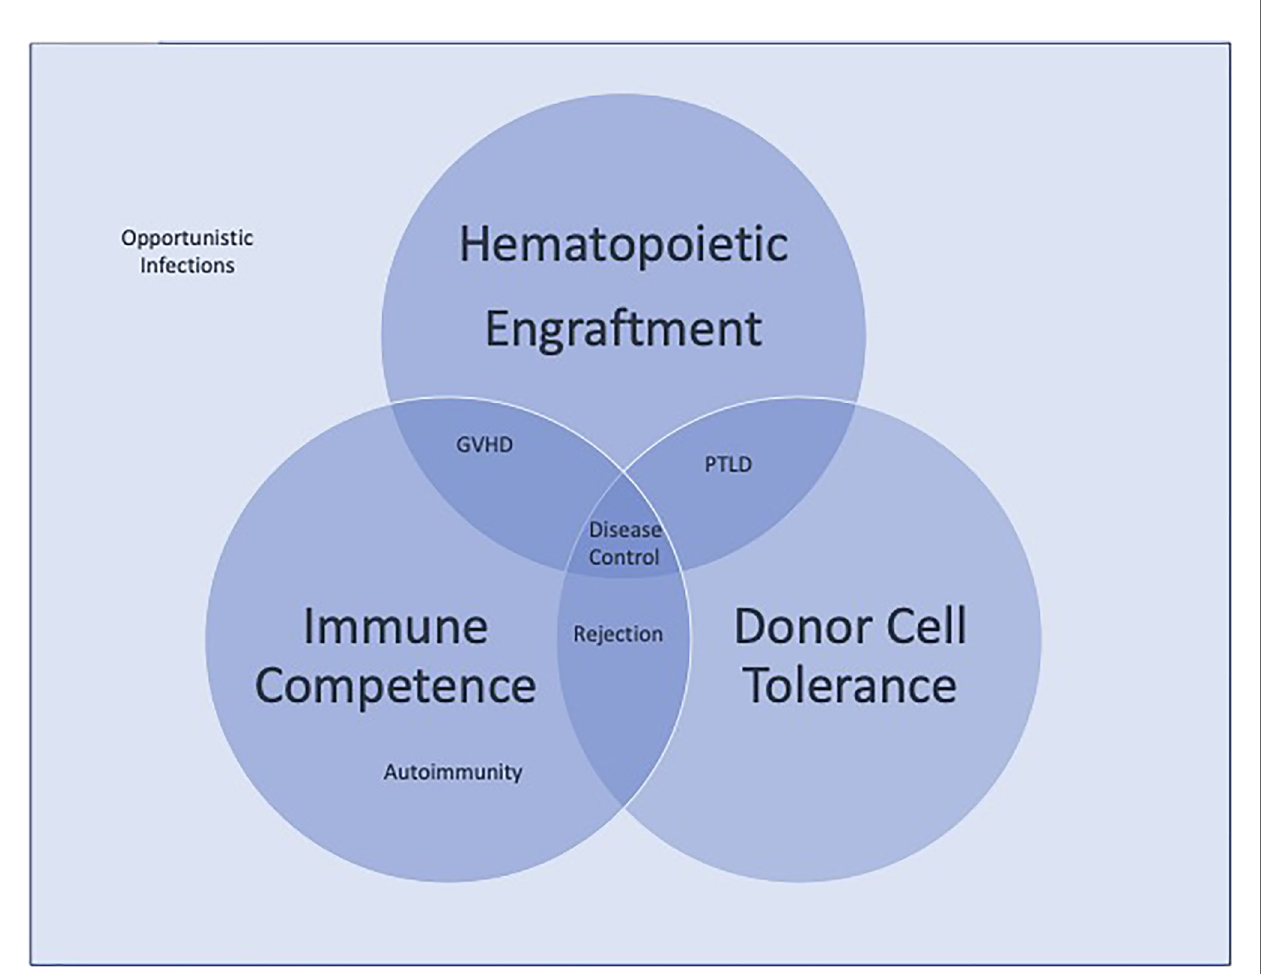
FIGURE 1 | Competing immunologic forces in hematopoietic stem cell transplantation. Disease control requires the balance of hematologic engraftment, immunologic competence, and donor cell tolerance. Failure to achieve all three leads to the clinical complications of transplantation